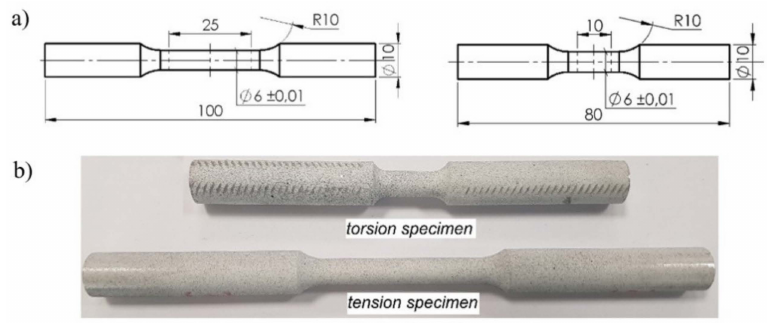
Figure 2. Smooth specimens of the ENAW_2024-T351 aluminum alloy used in tests. ( a ) Dimensions (unit: mm), ( b )